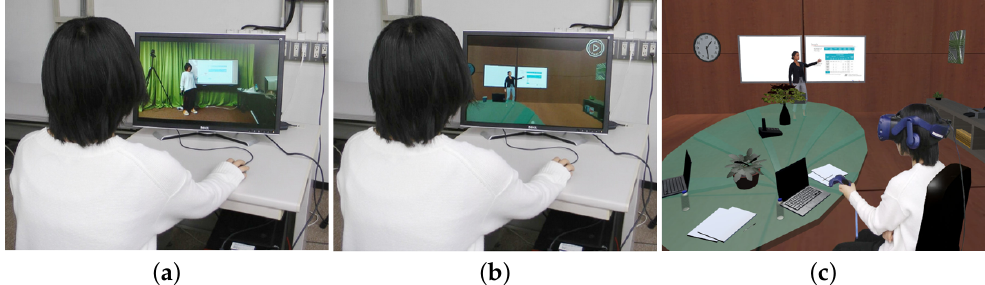
Figure 6. Experimental conditions for the checking participants’ own presentation. ( a ) Condition 1: Recorded video on a PC monitor. ( b ) Condition 2: Avatar constructed on the recorded information on the PC monitor. ( c ) Condition 3: Avatar constructed on the recorded information with a head- mounted